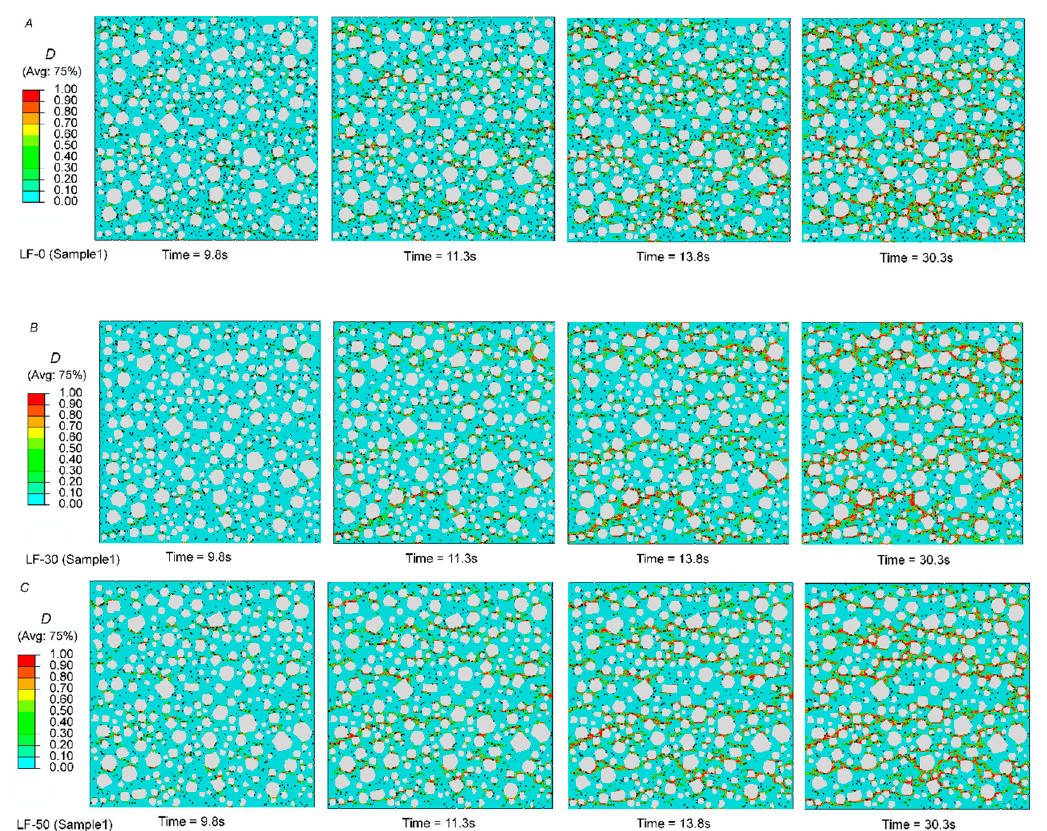
Figure 10. Evolution of the damage factor distribution of the mortar specimens LF-0, LF-30, and LF-50 at 28 days. ( A ) LF-0, ( B ) LF-30, ( C ) LF-50.